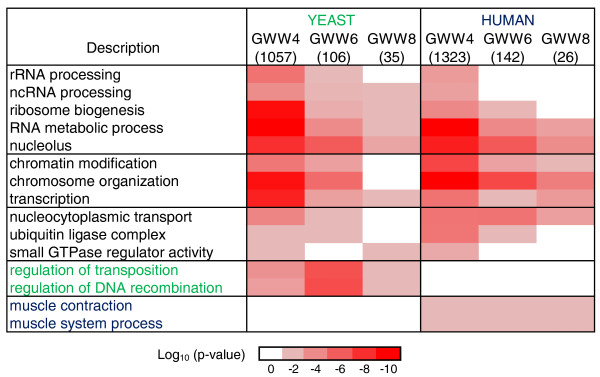
Significantly shared GO terms among predicted Gis2p and ZNF9 mRNA targets. GO term enrichments were assessed for predicted mRNA targets with GWW repeats of different lengths in CDSs. Numbers in brackets indicate the total number of genes in the respective group for which GO annotations were available. The color intensity corresponds to the log10 P-value. GO terms labeled in green were only enriched in yeast, the ones in blue only in human. ncRNA, non-coding RNA.